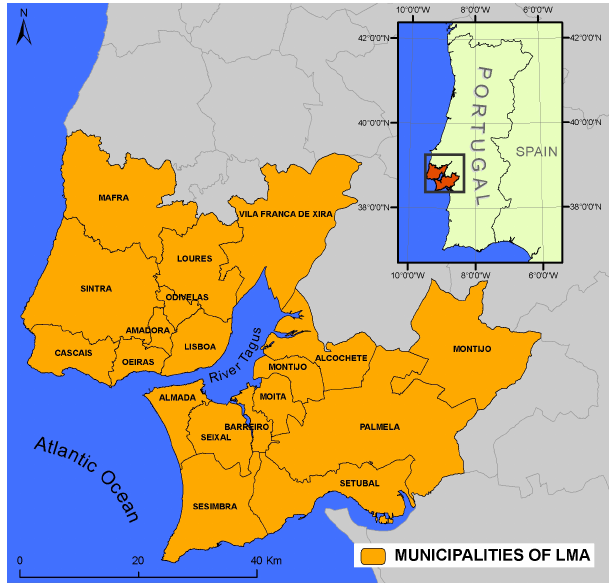
Fig. 1. Study area – Lisbon Metropolitan Area